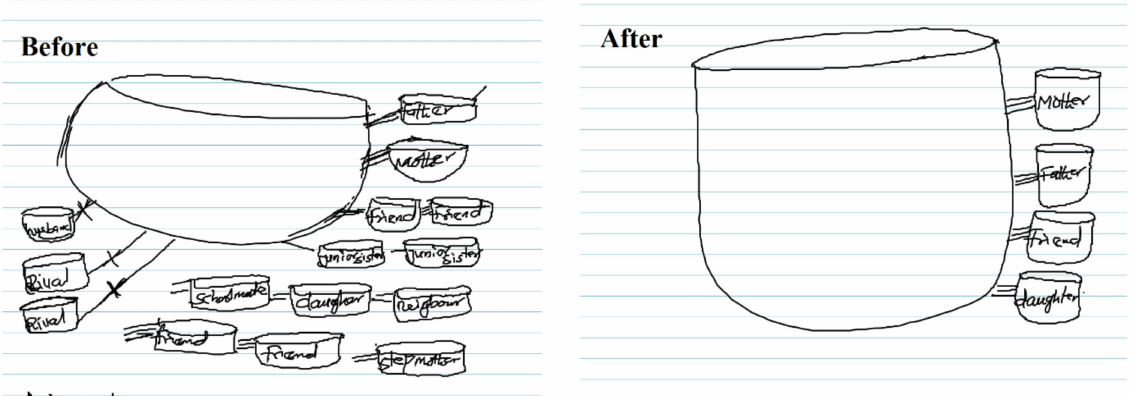
Figure 1. Iku ya ju j’esin lo [death is more preferable to shame] (SK15). Supportive social interactions tend to counteract the negative impact of shame, as one participant